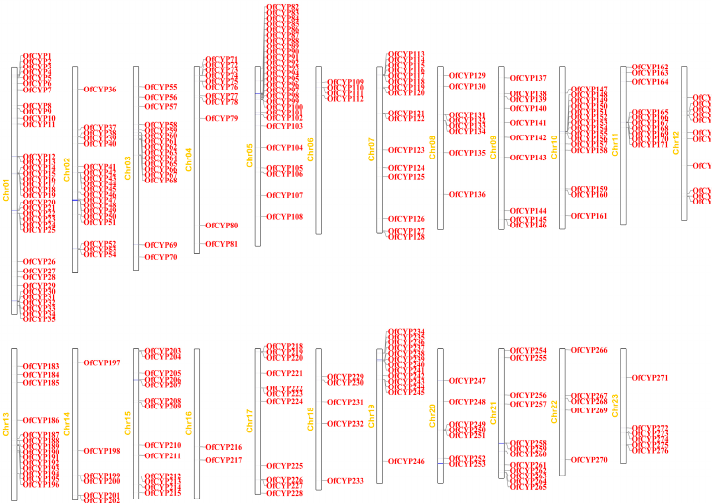
Figure 2. Chromosomal distribution of P450 genes in O. fragrans . The left scale indicates the length (Mb, megabases) of O. fragrans chromosomes.